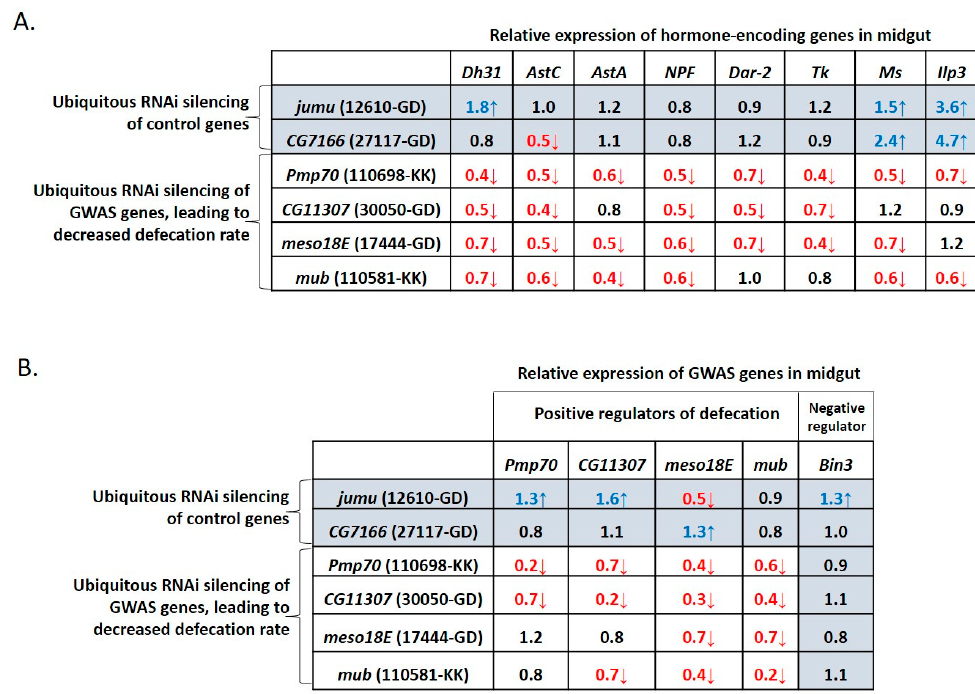
Figure 6. Midgut expression levels of hormone-encoding and GWAS genes upon ubiquitous downregulation of GWAS-identified positive regulator genes of the defecation rate. Relative expression levels of ( A ) hormones and ( B ) GWAS-identified genes associated with defecation rate, in the midgut of flies upon ubiquitous downregulation (via act-Gal4-UAS-RNAi) of positive regulators of the defecation rate, Pmp70 , or mub , or meso18E , or CG11307 , normalized to flies prepared from Gal4 lines crossed to w 1118 . Ubiquitous downregulation of either jumu or CG7166 was used as a control. Values indicated in red represent a ≥ 0.3 decrease (red arrow pointing down), whereas values in blue represent a ≥ 0.3 increase (blue arrow pointing up) from the baseline value of 1. Each number represents the average of six values.